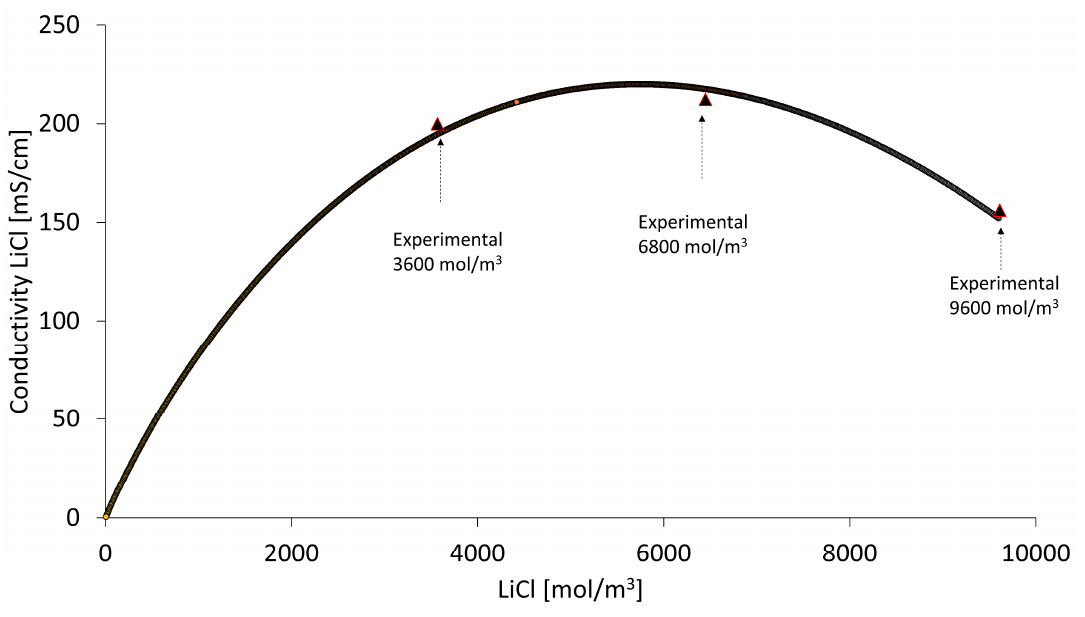
Figure 9. Electrolytic conductivity variation of LiCl with concentration.